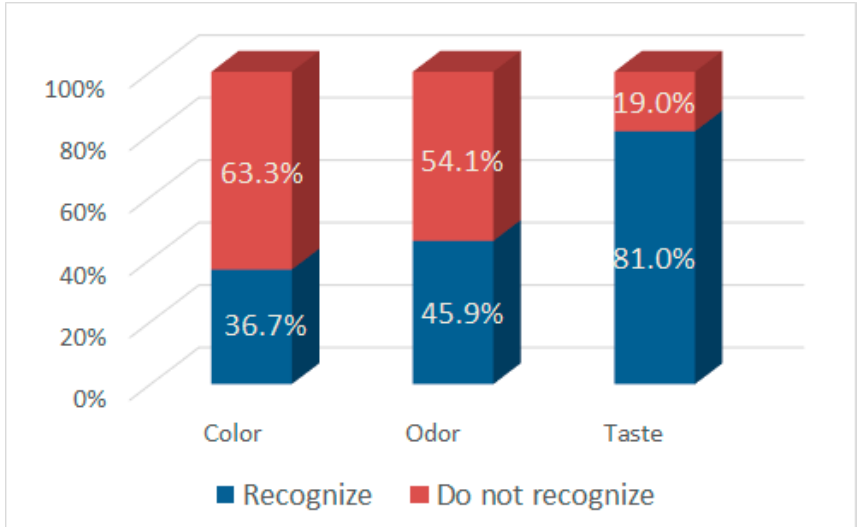
Figure 1. Consumer’s recognition of difference in color, odor and taste between cheeses.